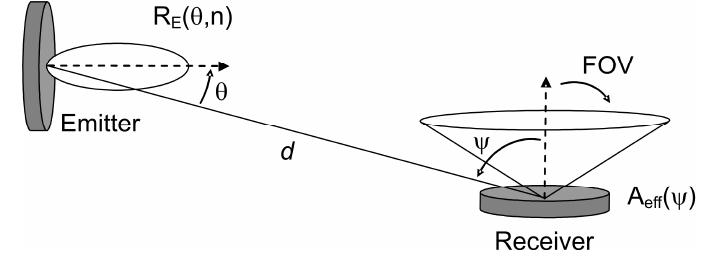
Figure 1. Emitter and receiver geometry without reflector.